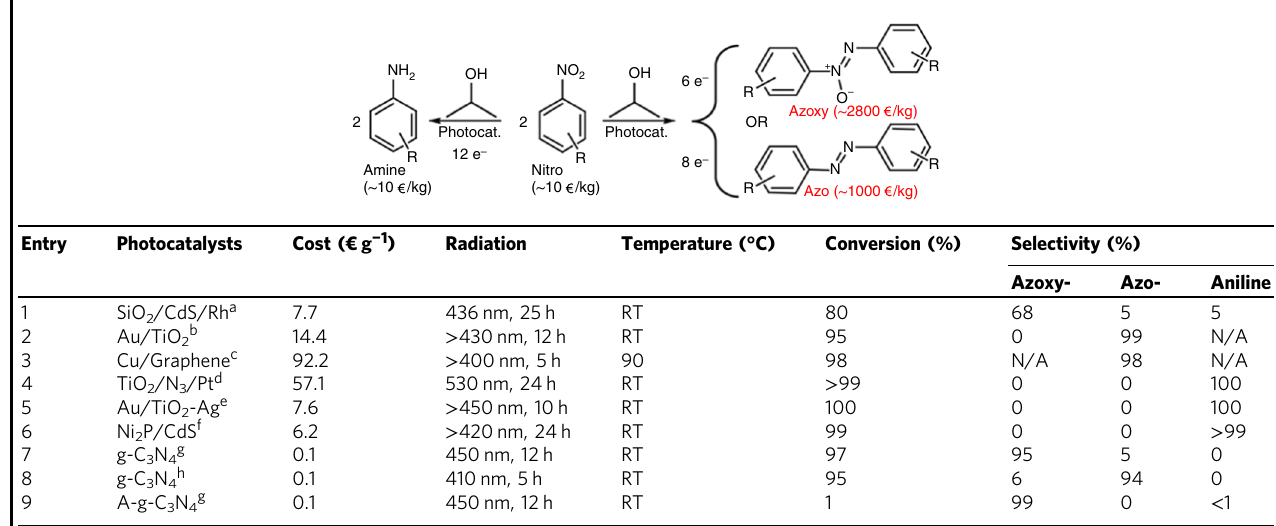
Table 1 Possible products formed by photocatalytic reduction of nitroaromatic compounds and comparison of the conversion and selectivity of different photocatalysts